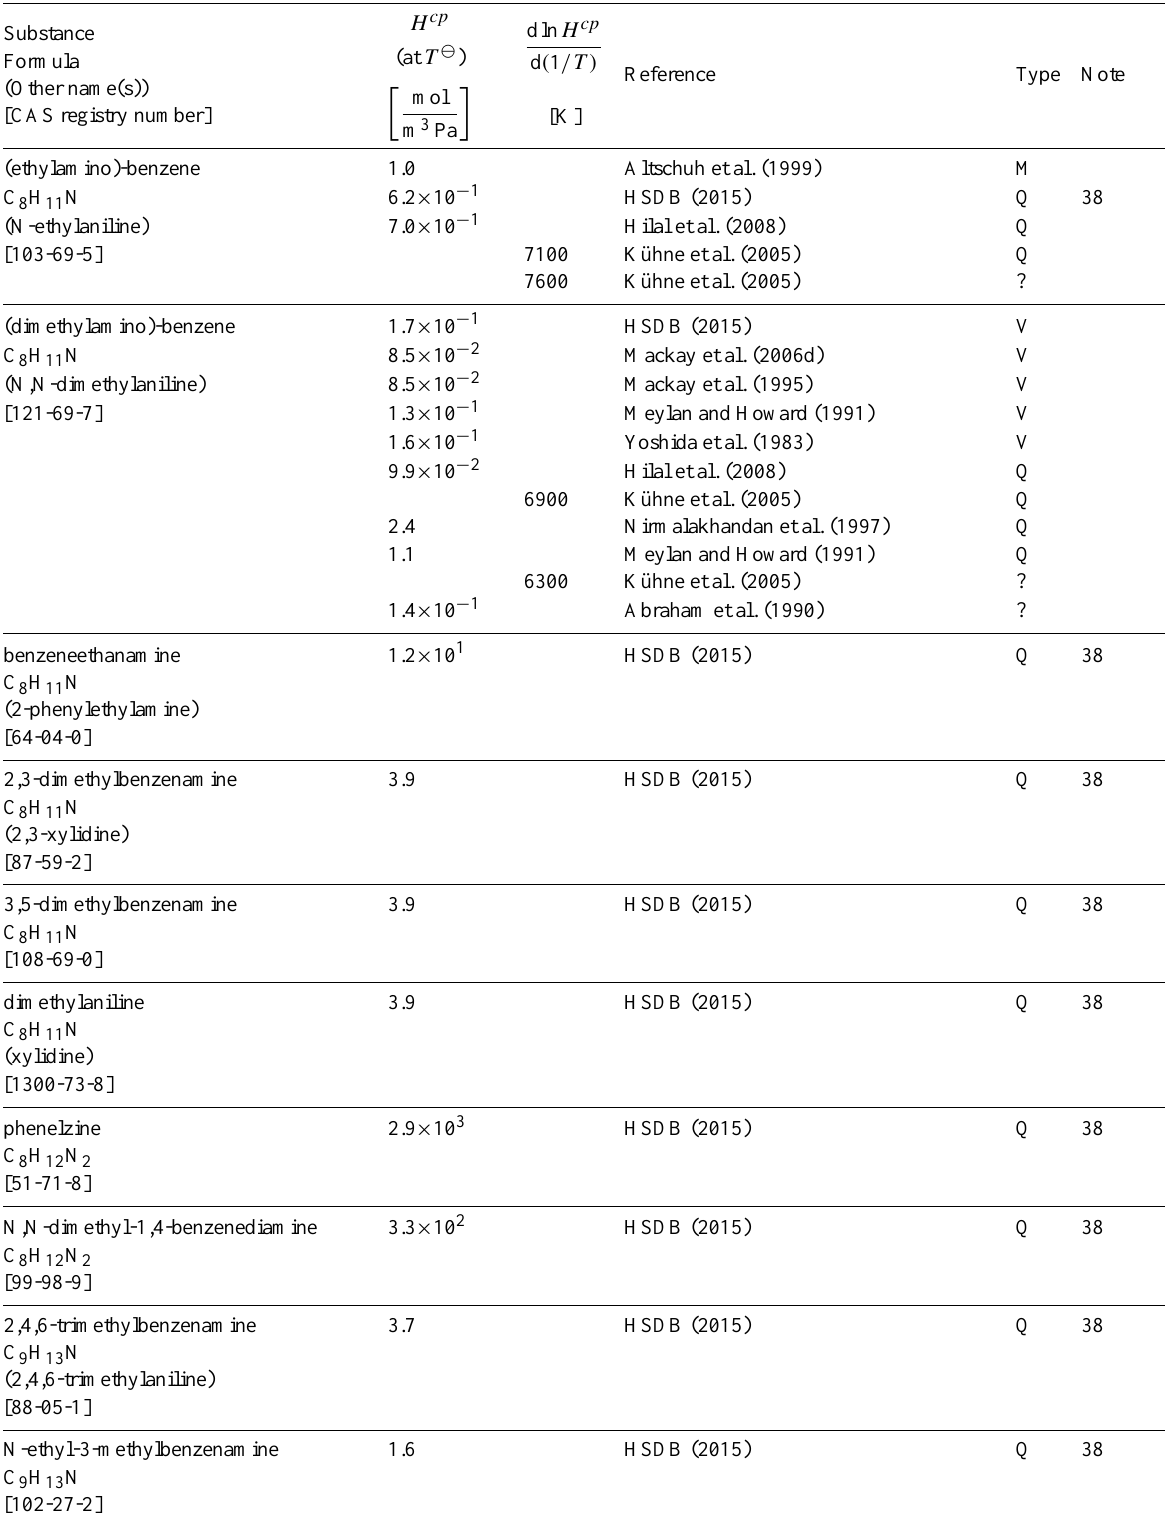
Table 6: Henry’s law constants for water as solvent